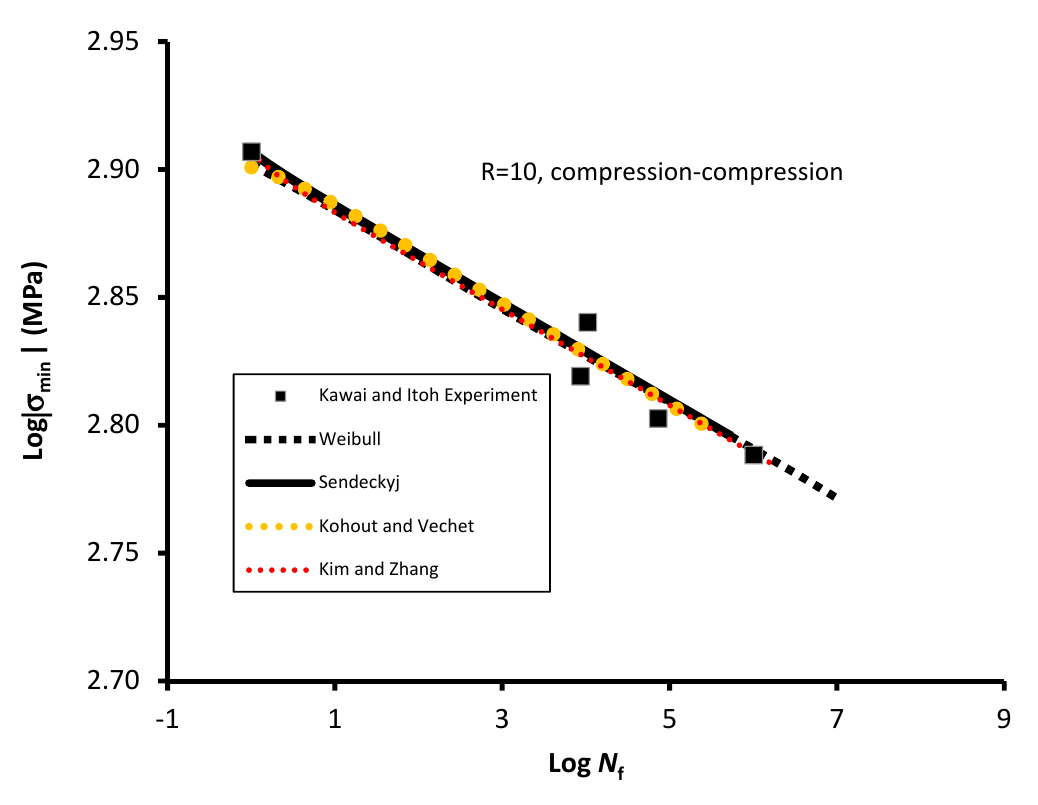
Figure 9. Kawai and Itoh experimental data [22] for carbon fiber reinforced epoxy laminates with σ uC = 807 MPa and σ uT = 1887 MPa, and S-N curves obtained from: Weibull model with α = 0.138, β = 0.66, and assumed σ ∞ = 185 MPa; Sendeckyj model with α = 1.3 and β = 0.019; Kohout and Vechet model with α = 1 and β = − 0.02; and Kim and Zhang model with α = 2.88 × 10 − 160 , β = 54.388 and N 0 = 1. Table 1 lists selected S-N curve models with two or less fitting parameters for data presentation.